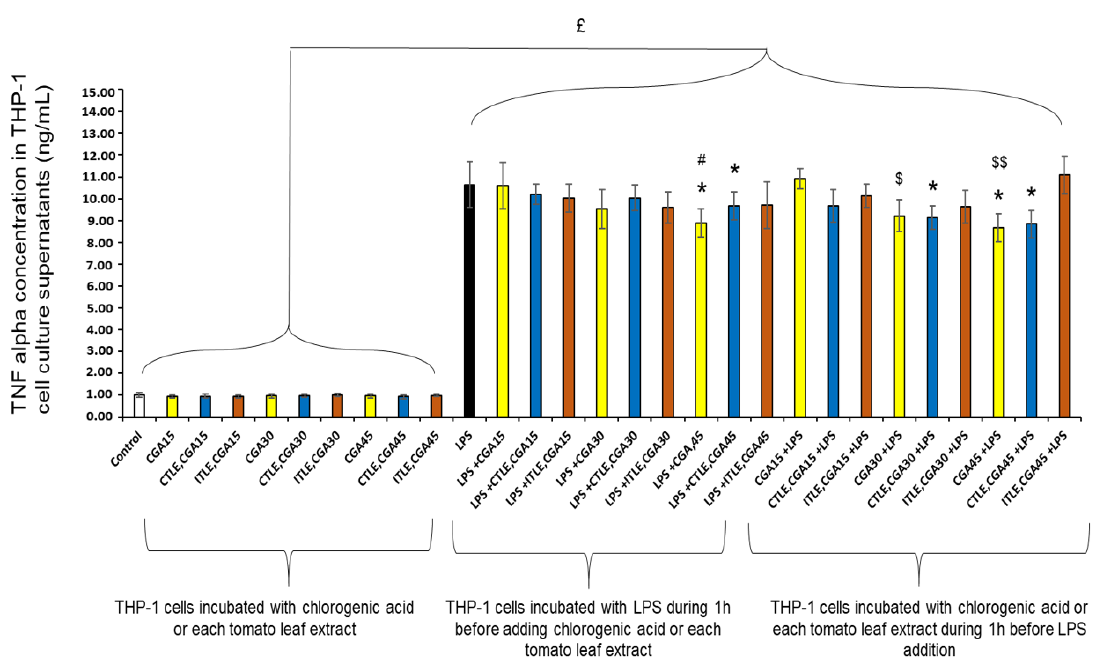
Figure 6. Anti-inflammatory activity of tomato leaf extracts and CGA on differentiated THP-1 cells. Extracts of tomato leaves infested (ITLE) or not (CTLE) with T. absoluta were evaluated. Three concentrations, 50, 100, and 150 µ g/mL, respectively, corresponding to 15, 30 and 45 µ g/mL of chlorogenic acid (CGA) were used. CGA was also used as a reference. Differentiated THP-1 cells were incubated for 24 h either with a tomato leaf extract, CGA alone or with 100 ng/mL of LPS added one hour before or after the addition of a tomato leaf extract or CGA. Cell culture supernatants were then collected and used to quantify TNF- α production by ELISA. “Control” corresponds to a THP-1 cell culture in which no product was added (negative control). “LPS” corresponds to a THP-1 cell culture in which only LPS was added (positive control). “LPS + tomato leaf extract,15” indicates that LPS was added before the tomato leaf extract in which the concentration of CGA is 15 µ g/mL while “tomato leaf extract,15 + LPS” indicates that the tomato leaf extract containing CGA at 15 µ g/mL was added before LPS. This figure is representative of six independent experiments performed in triplicates. Data are presented as the mean ± S.D. t -tests were used to identify statistically significant differences. £ p < 0.05 vs. conditions without LPS. * p < 0.05 vs. LPS alone; $ p < 0.05, $$ p < 0.01 vs. CGA,15 + LPS; # p < LPS + CGA,